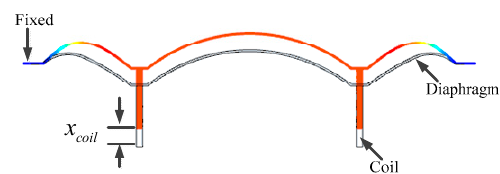
Figure 17. Static analysis to obtain effective area.